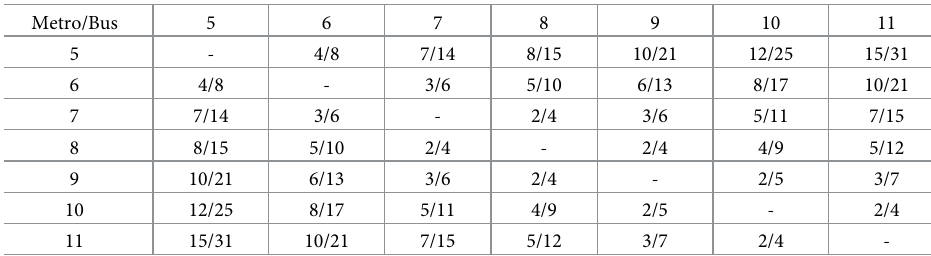
Table 3. The riding time of metro/bus